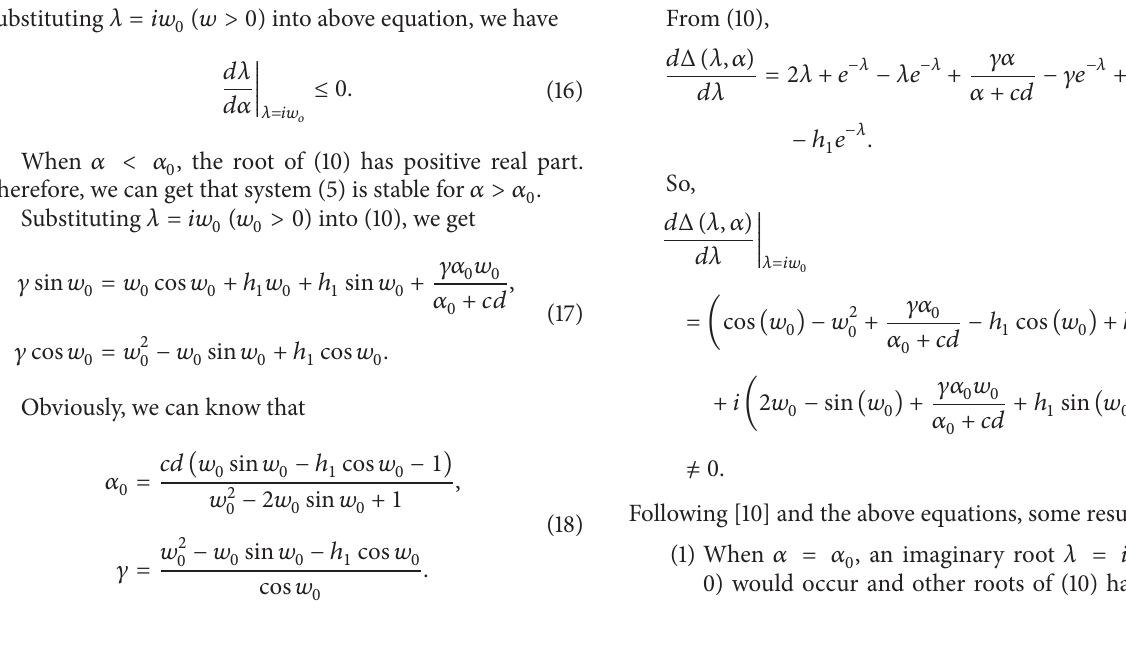
When 𝛼 < 𝛼 0 , the root of (10) has positive real